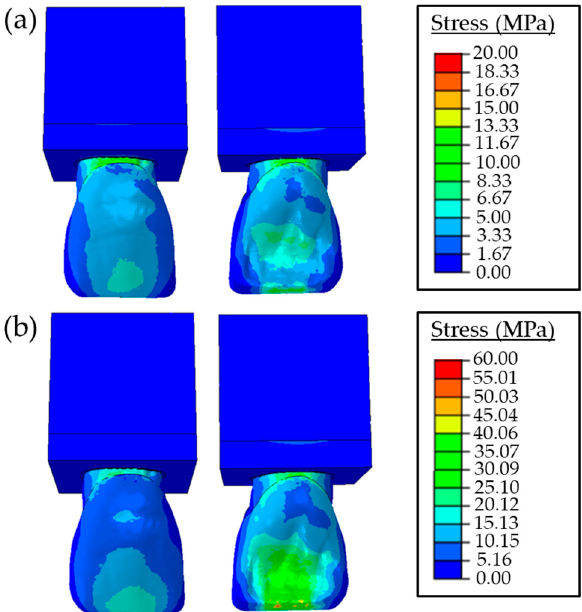
Figure 4. Stress values of the sound tooth with ( a ) the protrusive movement due to a horizontal force of 15 N with 90 ◦ angle and ( b ) the tearing function due to an oblique force of 50 N with 60 ◦ angle. The stresses increased proportionally with the magnitude of the applied force con- cerning the protrusive movements and tearing function. The maximum von Misses stress values of the sound tooth model were found around 20 MPa and 59 MPa for loading with a 15 N 90 ◦ angle and 50 N 60 ◦ angle,